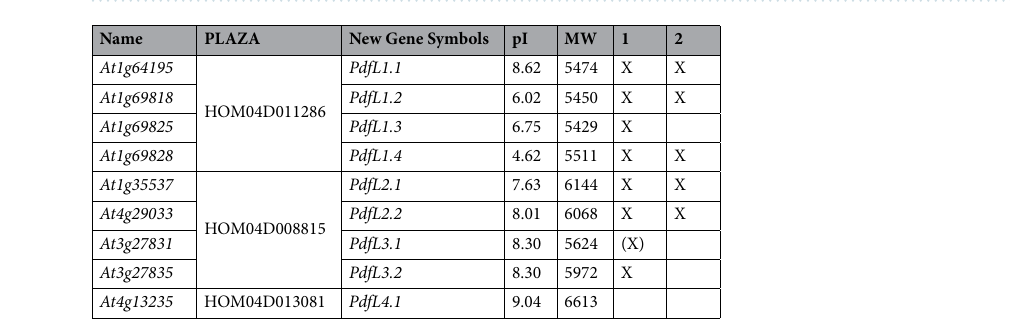
Table 1. MW and pIs of PDFL mature peptides. 1, orphans according to Lin et al. 55 ; 2, orphans according to Donoghue et al. 54